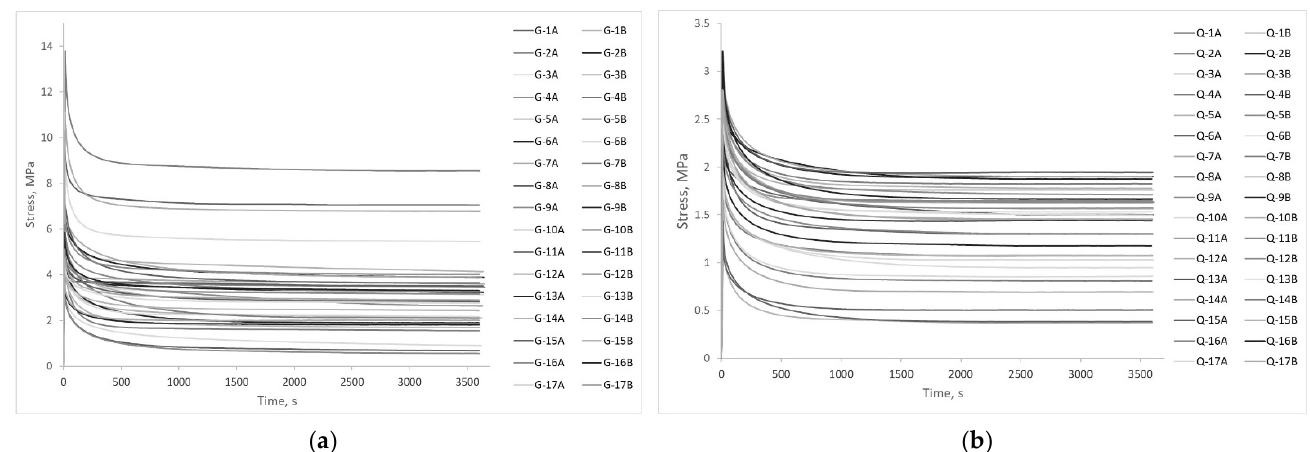
Figure 12. ( a ) Stress-relaxation test of gracilis tendons; ( b ) Stress-relaxation test of quadriceps tendons.